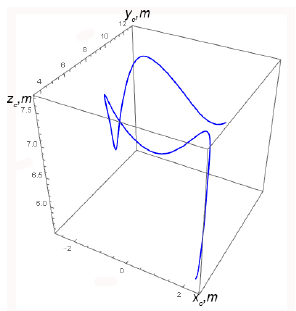
Figure 19. 3D trajectory of the center of mass of the beam (p. C )